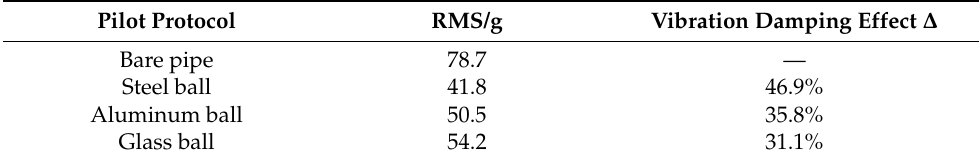
Figure 10. Spectral responses of damped pipeline with different materials at an 80% filling rate. Table 2. Three materials with an 80% filling rate under random excitation.